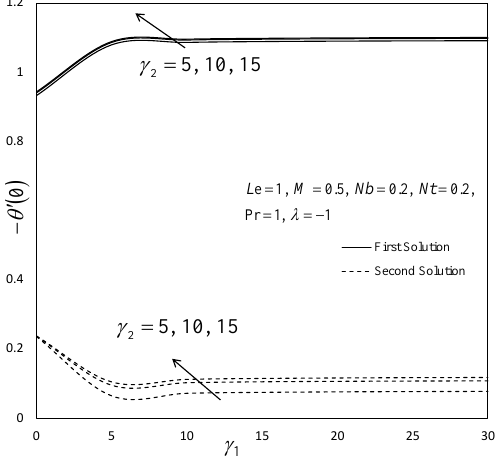
Figure 13. Variations of − θ (cid:48) ( 0 ) towards γ 1 for selected values of γ 2 .